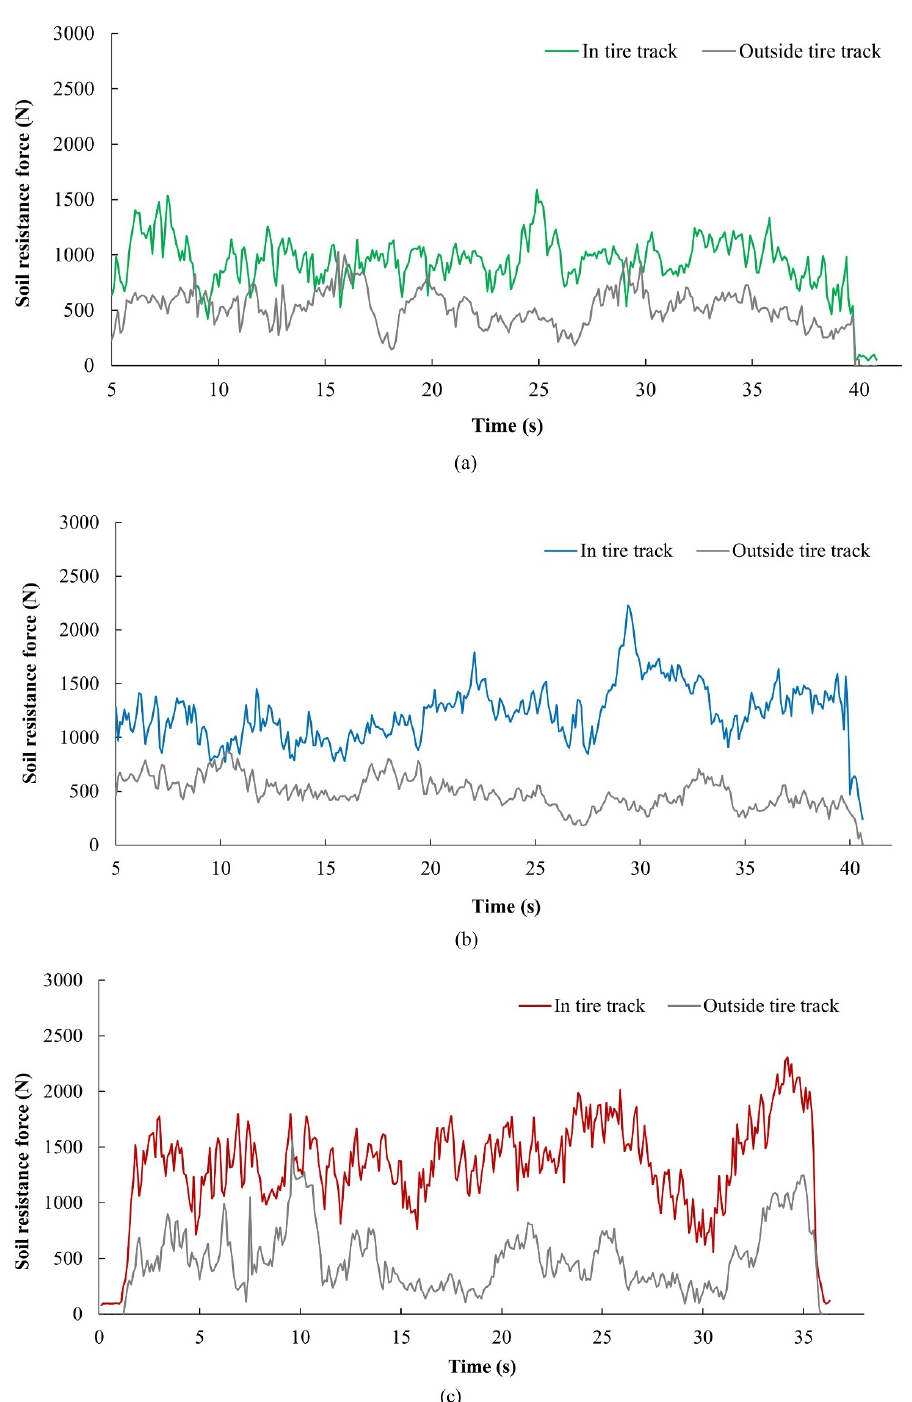
Figure 14. Results of experimental measurements: ( a ) one passage; ( b ) two passages; ( c ) three pas- sages.